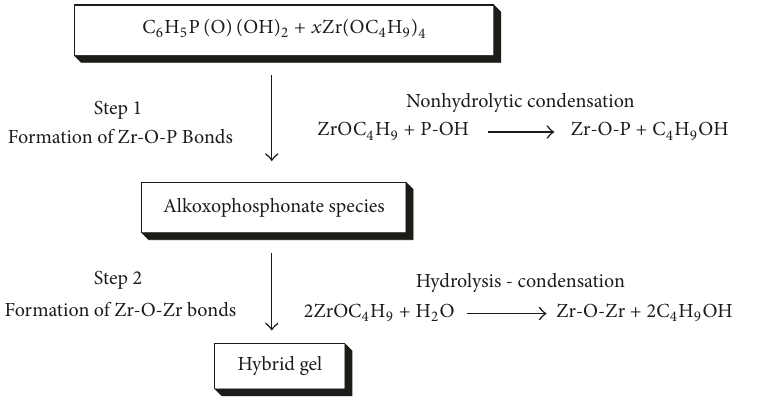
Scheme 1: Representation of the two-step sol-gel process.